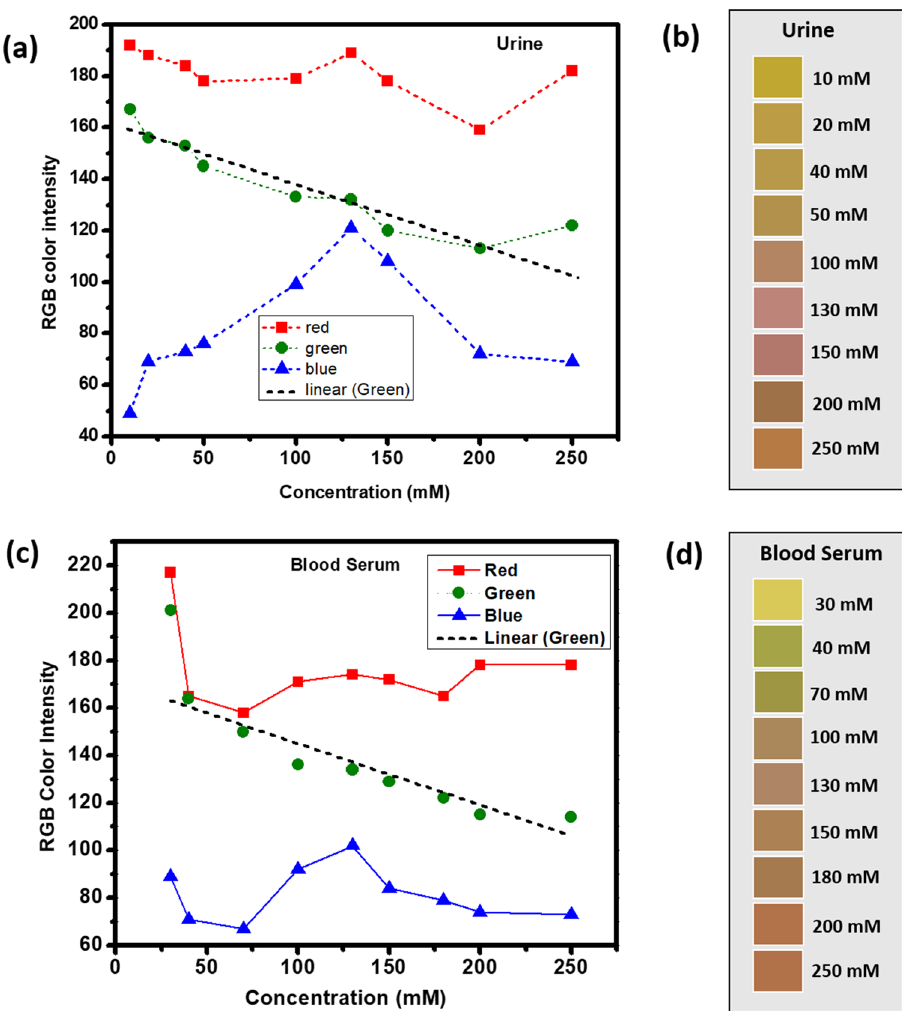
Figure 11. The plot of RGB analysis of digital images of the paper test strips ( a ) urine and ( c ) blood serum. Corresponding shade cards representing Na + concentration ( b ) urine and ( d ) blood